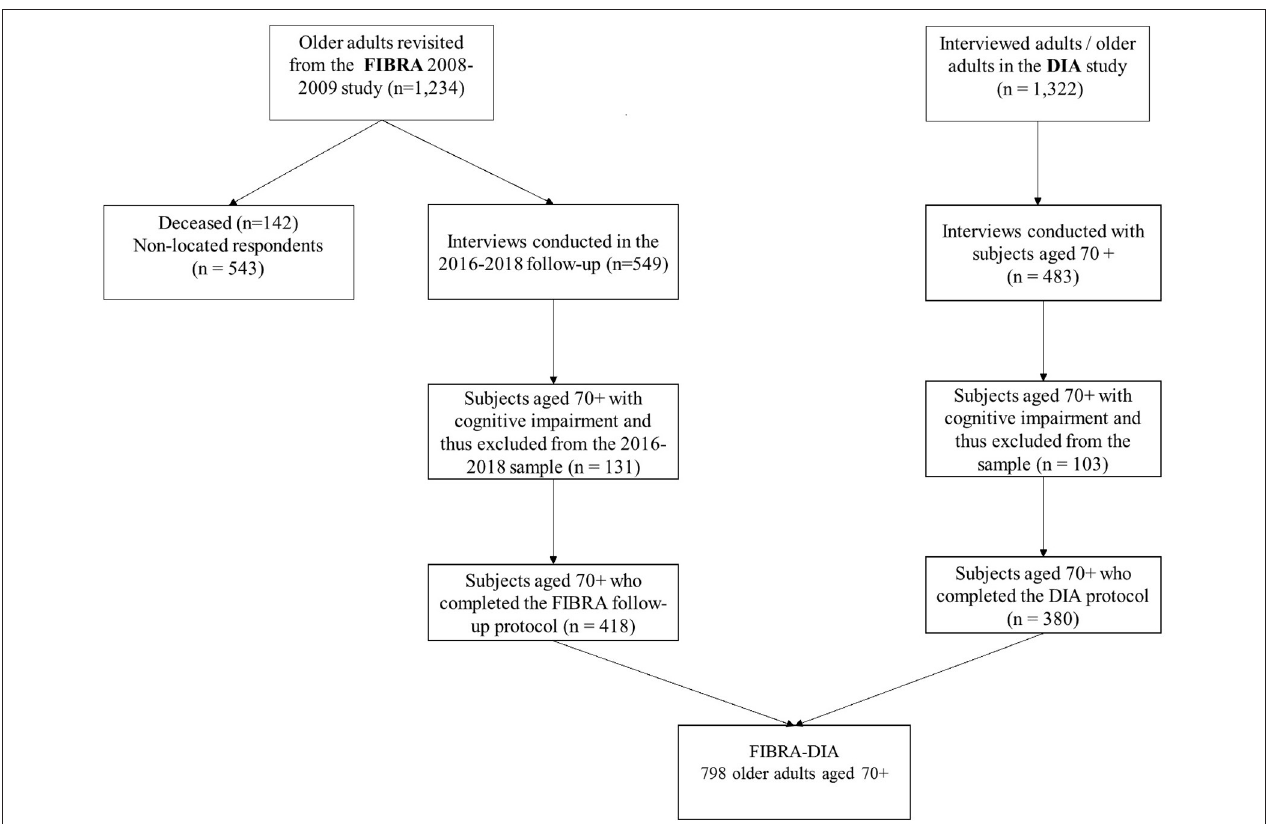
FIGURE 1 | Sample